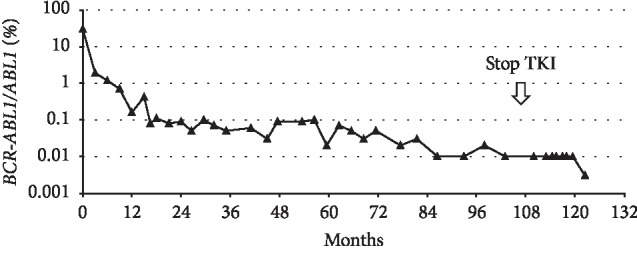
Patient BCR-ABL1 levels throughout disease course.